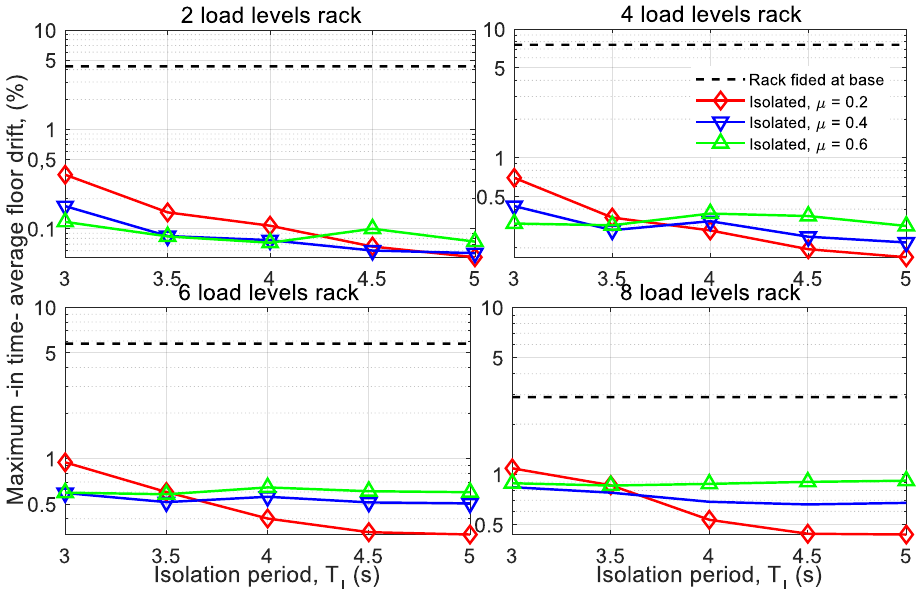
Figure 9. Maximum drift in racks with basal isolation with different load levels, friction coefficient ( μ ) and isolation period ( 𝑇 𝐼 ). The black dotted line is the response for fixed base racks.